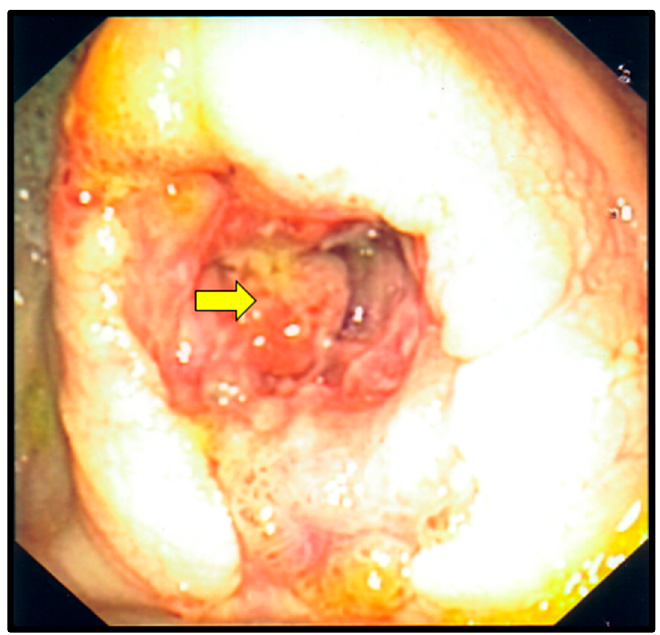
Figure 4. Colonoscopy. The yellow arrow points to a large ulcerative mass in the cecum, which was secondary to gastrointestinal histoplasmosis.